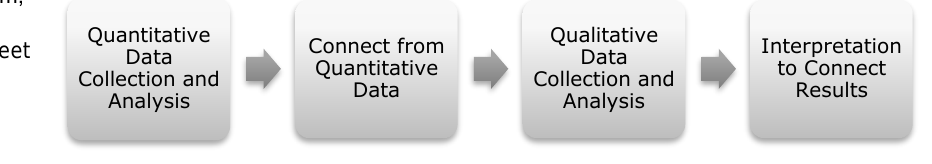
Figure 2. Sequential explanatory design. This form of mixed methods outlines a process starting with quantitative data